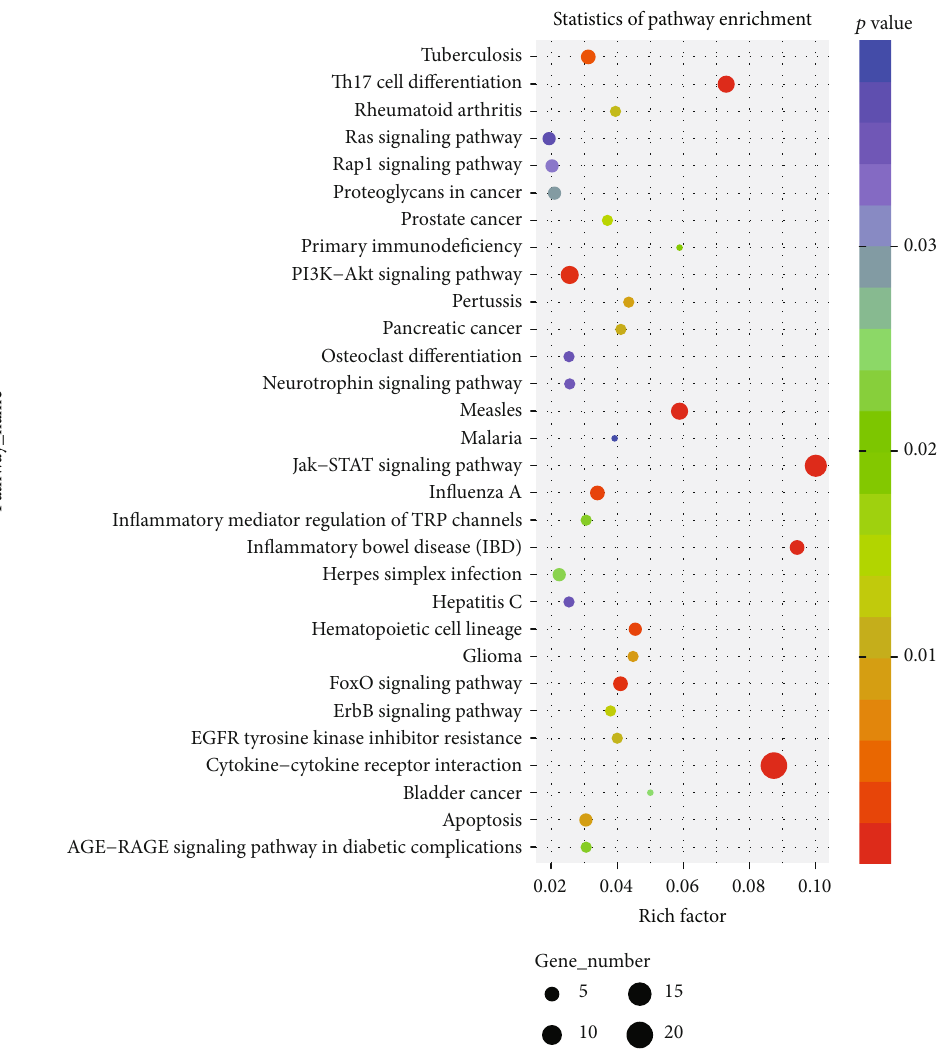
Figure 5: The results of KEGG enrichment analysis. Rich factor represented the number of di ff erent genes located in the KEGG/the total number of genes located in the KEGG. The greater the rich factor value was, the greater the degree of KEGG enrichment would